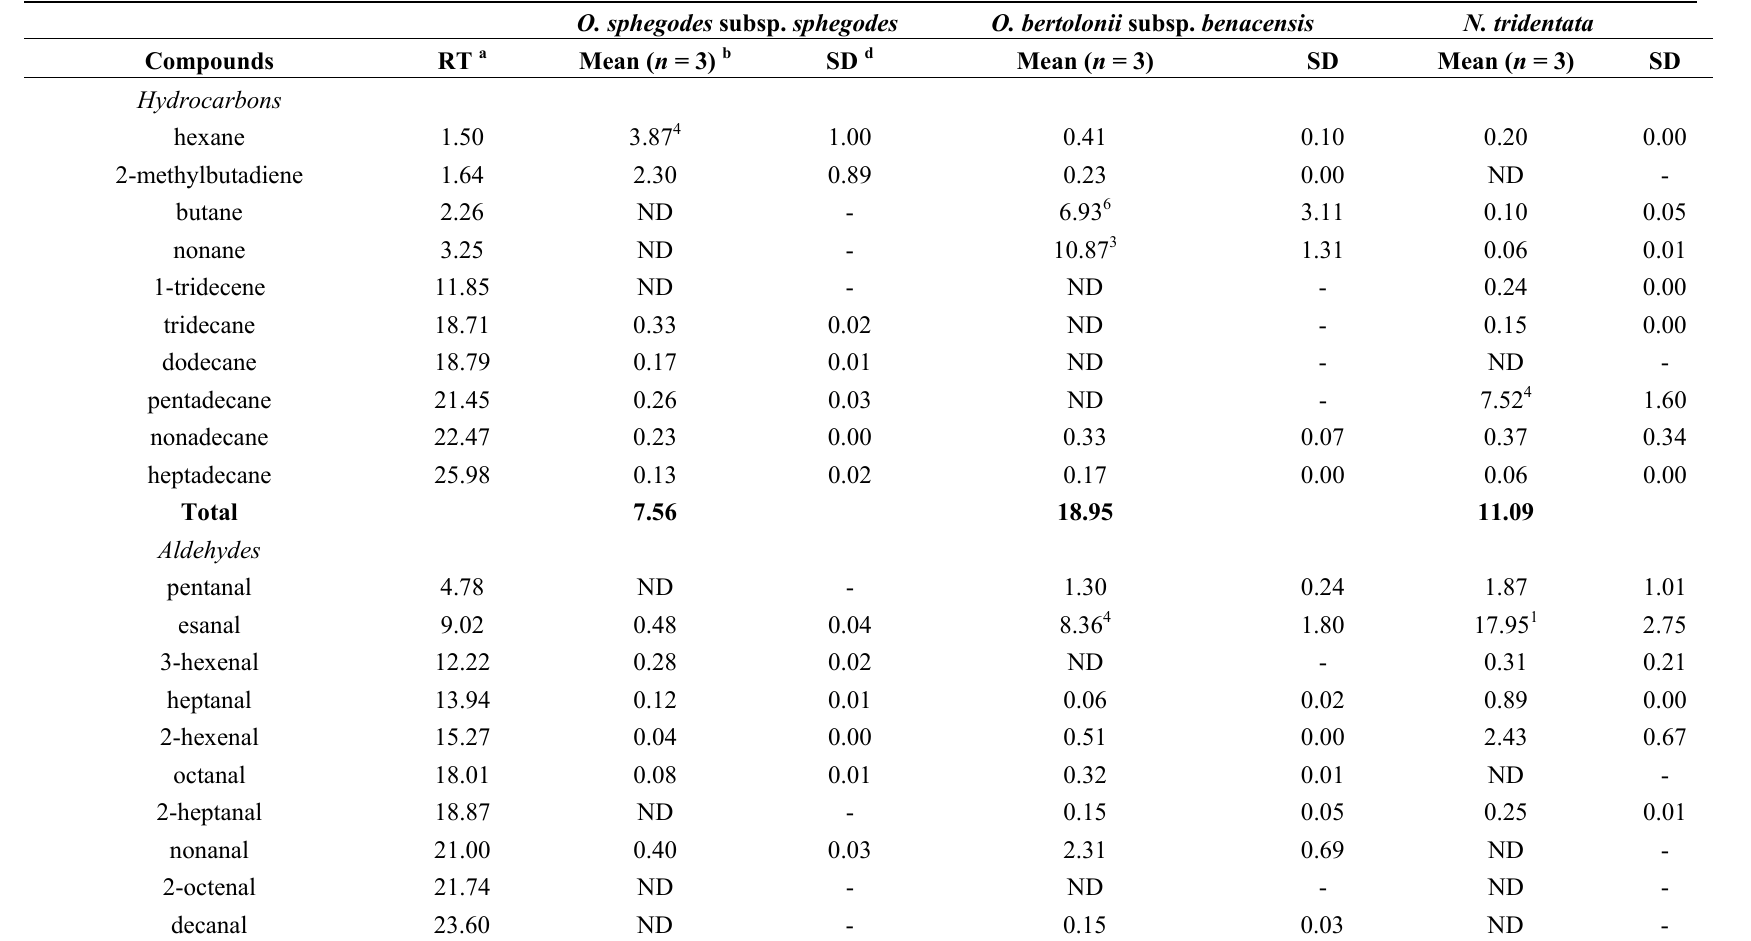
Table 2. Identification of volatile organic compounds by HS-SPME-GCMS from picked flowering orchid samples. O. sphegodes subsp. sphegodes O. bertolonii subsp. benacensis N.